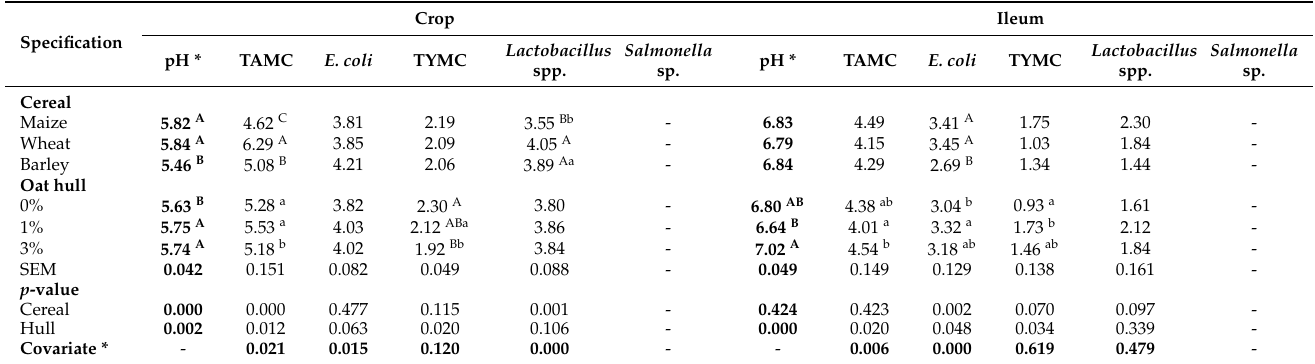
Table 6. Counts of microorganisms in crop and small intestine (log CFU · g − 1